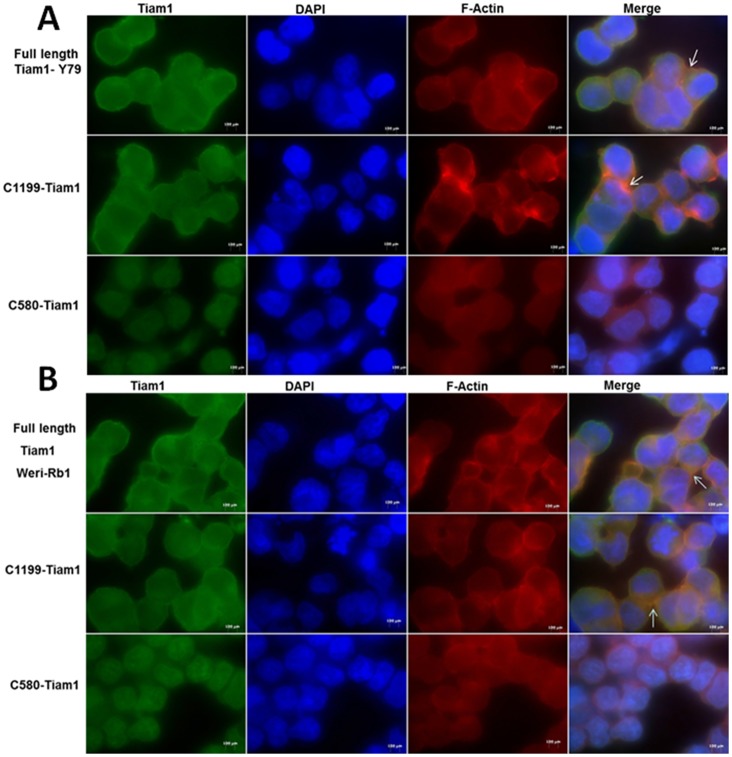
Localization of Full length Tiam1, C1199 Tiam1 and C580 Tiam1 in RB cell lines.A) Immunofluorescent images of Y79 cells, B) Weri-Rb1 cells transfected with Full length Tiam1, C1199 Tiam1 and C580 Tiam1 plasmids tagged with HA. Tiam1 and F-actin were stained as mentioned in the materials and methods. Full length Tiam1 and C1199 Tiam1 but not C580 Tiam1 were localized to plasma membrane. Unlike Full length Tiam1 and C1199 Tiam1, C580 Tiam1 could not induce membrane ruffling. Representative images were taken from 10 independent fields using AxioObserver fluorescent microscope at 100× and arrows indicate the membrane ruffling. Scale bar: 20 μm.